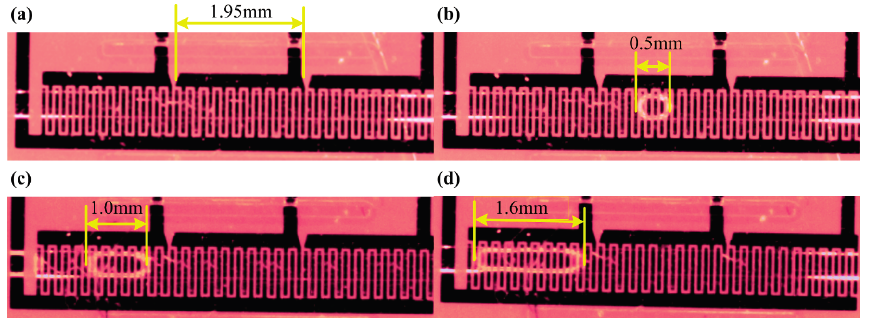
Figure 7. Optical images for oil droplets in continuous water. ( a ) Sensing unit; each gives an effective sensing length of 1.95 mm while connected; ( b ) oil droplet with 0.5 mm length; ( c ) oil droplet with 1.0 mm length; ( d ) oil droplet with 1.6 mm